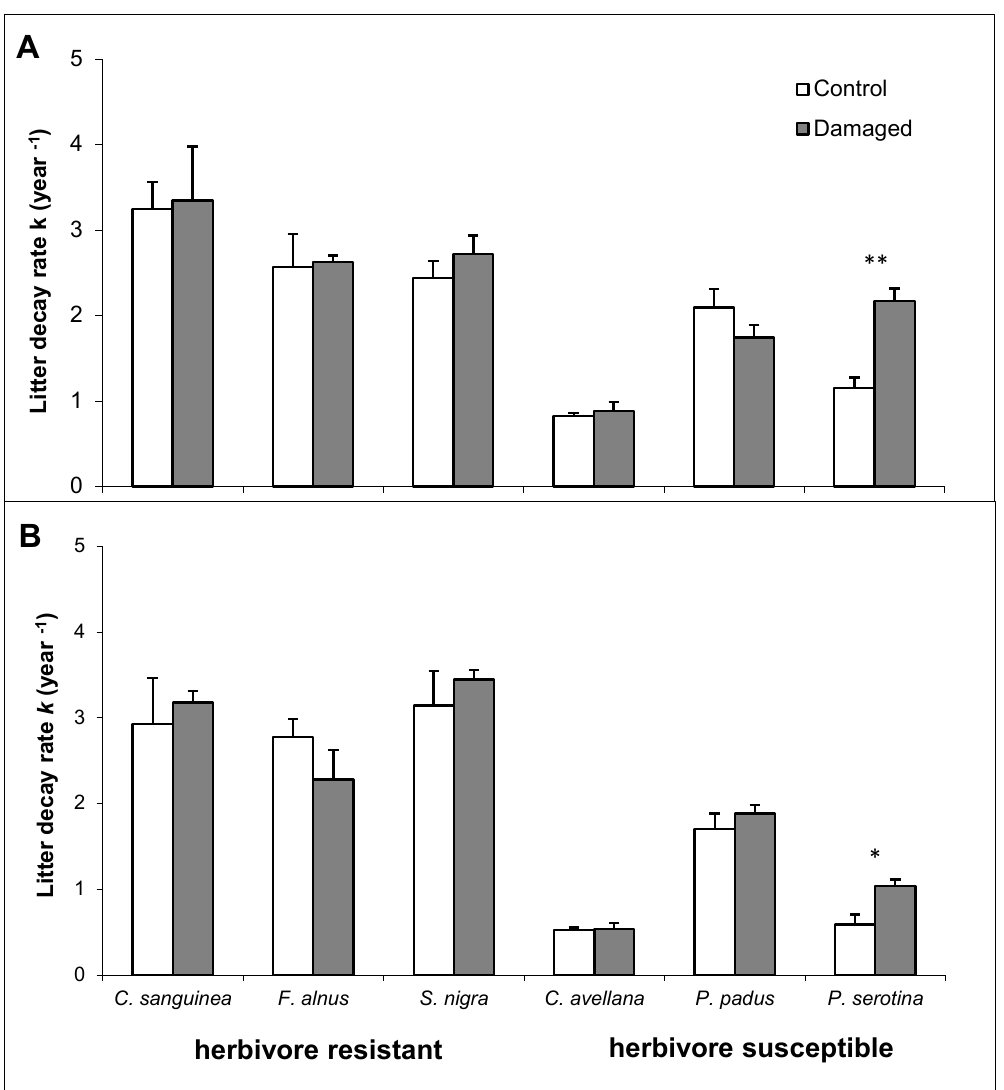
Figure 1. Coefficients of leaf litter decomposition (mean ± SE) of six understory plant species (the three species on the left are resistant and the three on the right are susceptible to herbivory) in two stand species ( n = 3; three bags/species in each stand/damage treatment): ( A ) oak and ( B ) pine monoculture. Significant differences between control and damaged and leaves within the same plant species are shown with asterisks (* p < 0.05 and ** p < 0.01).